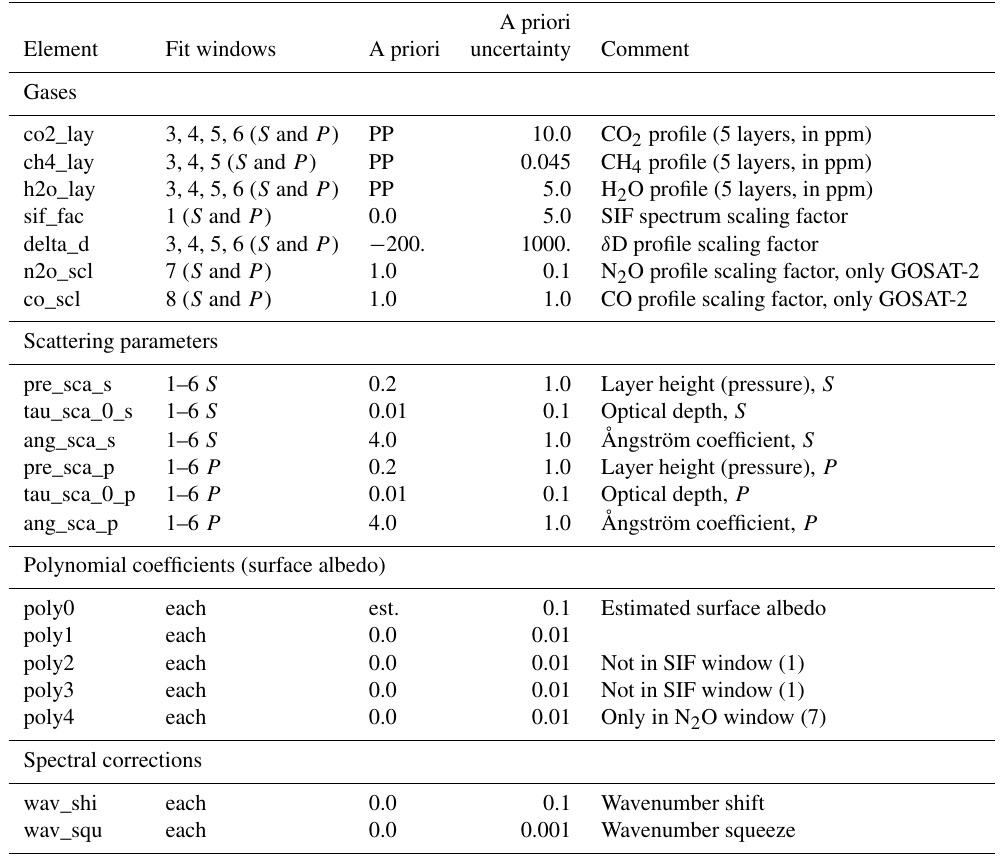
Table 3. State vector elements and related retrieval settings. A priori values are also used as first guess. The “Fit windows” column lists the spectral windows (see Table 2) from which the element is determined; “each” means that a corresponding element is fitted in each fit window. A priori values labelled as “PP” are taken from pre-processing; “est.” denotes that they have been estimated from the background